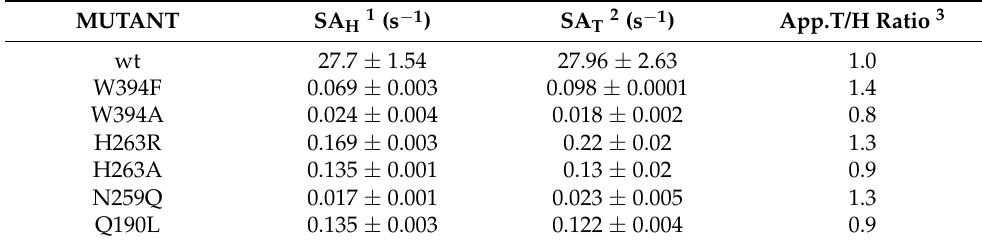
Table 3. Specific activities (SA H , SA T ) for transglycosylating LnbB mutants.